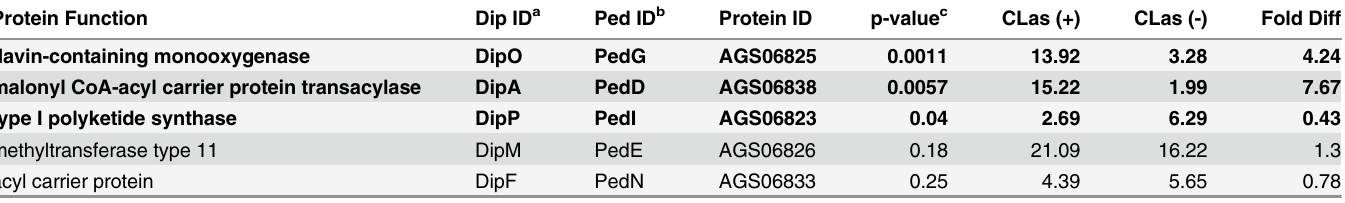
Table 1. Profftella polyketide metabolism proteins identified from analysis of mass spectrometry data. Proteins differentially expressed between CLas(+) and CLas(-) D . citri are marked in bold (N = 3, p < = 0.05, fold difference > = 2 or < = 0.5). Average normalized peptide count from specified proteins and fold difference: